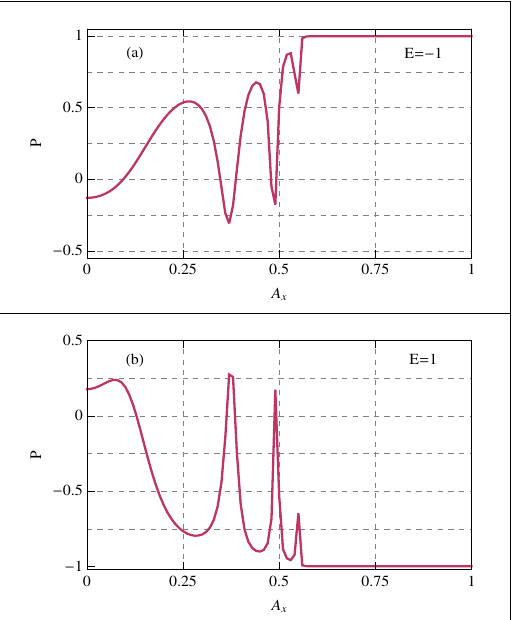
Figure 3. P - A x characteristics at two distinct energies. All the other physical parameters kept unchanged as taken in Figure